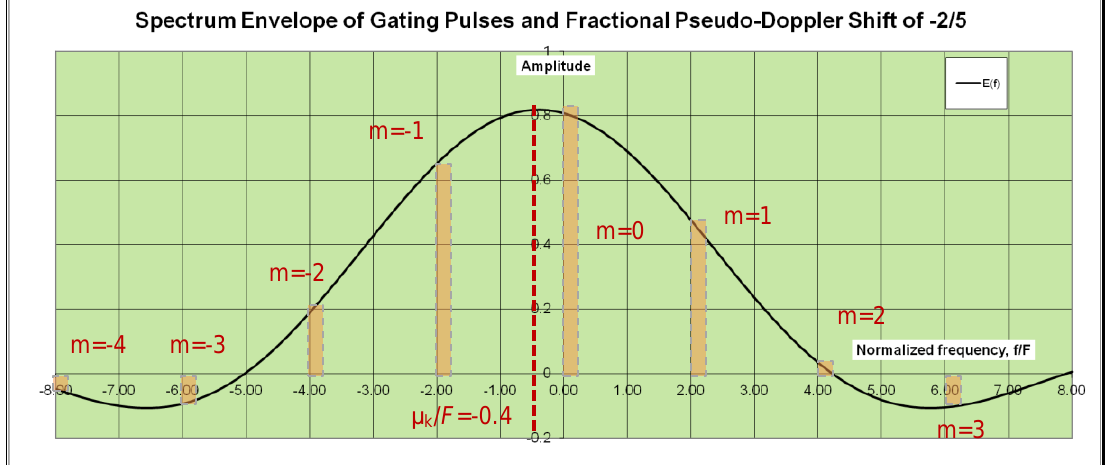
Figure 13. Spectral envelope and replicas for OAM with k = 8.